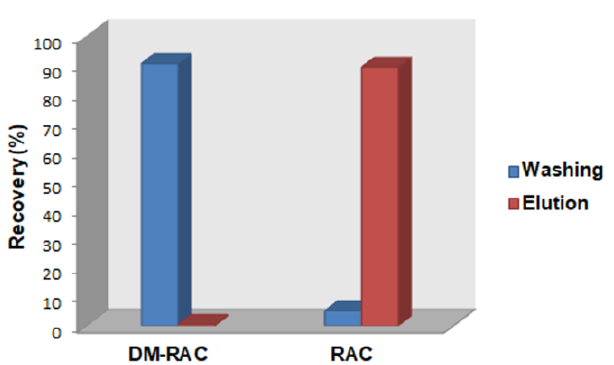
Figure 9. Recovery yield in the washing and elution steps obtained loading RAC-MISPE cartridge with a solution containing an excess of DM-RAC (1000 µg mL −1 ) compared to RAC (10 µg mL −1 ).